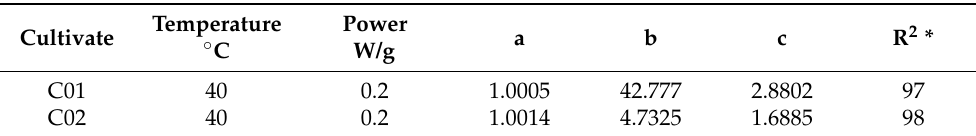
Table 1. The Bleasdale model parameters adjusted for the reduction of the water content in soybean seeds treated with the magneto-priming.